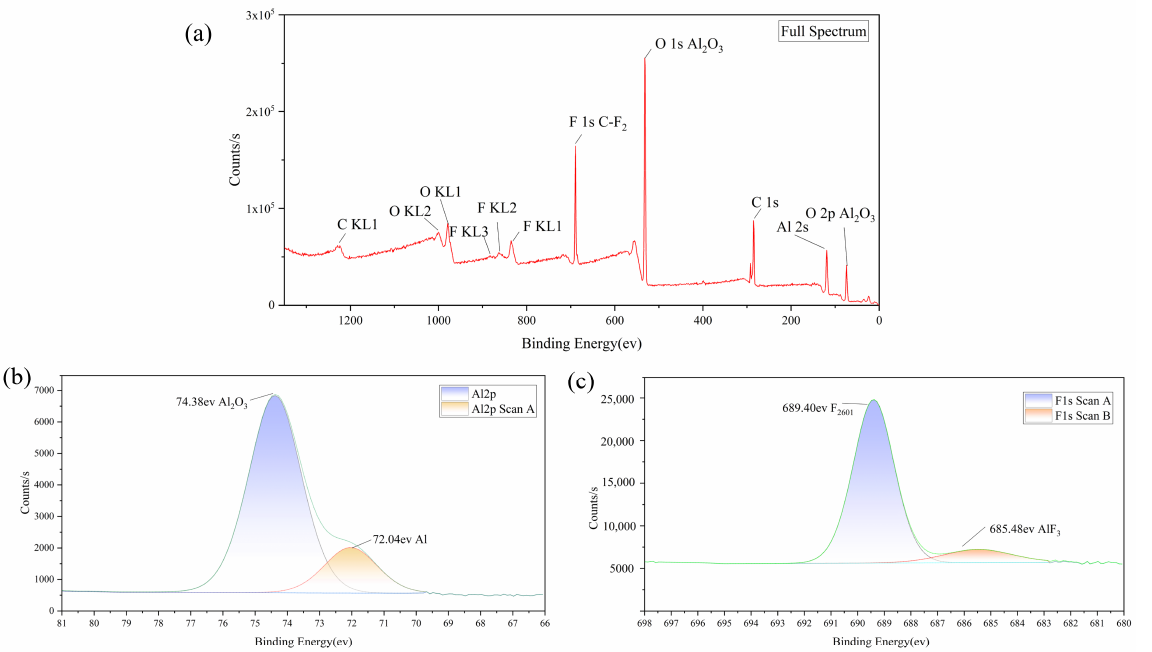
Figure 5. XPS of the micro-nano composite aluminum powder. The full spectrum ( a ), the element Al ( b ), and the element F ( c ).